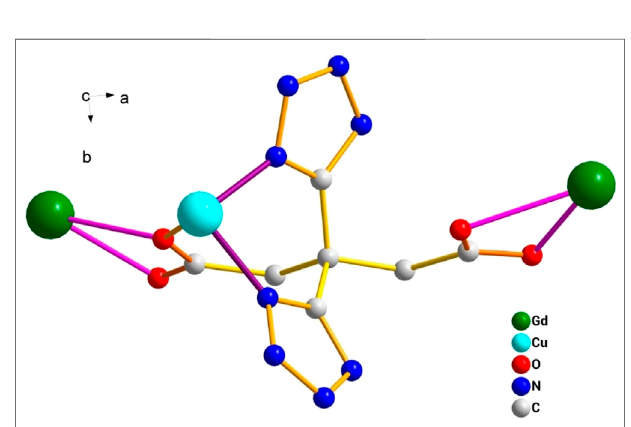
FIGURE 3 | Coordination mode diagram of the H 4 L.